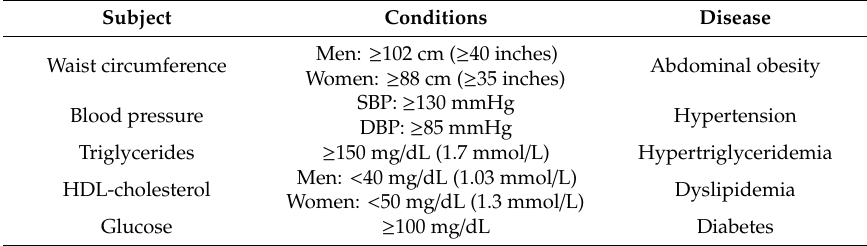
Table 1. Conditions of metabolic syndrome.